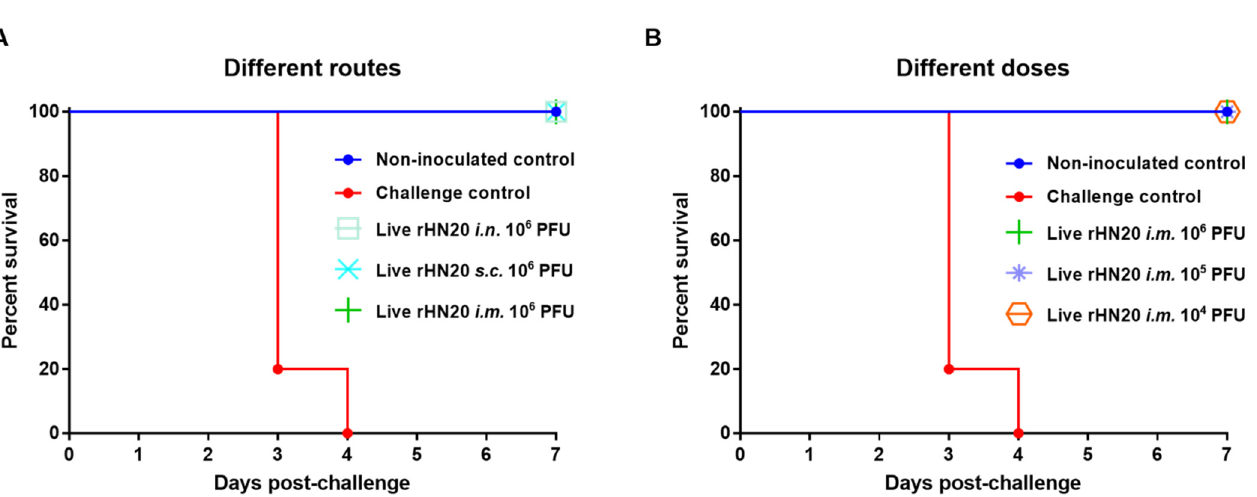
Figure 3. Protective efficacy of live rHN20 vaccine candidate against FAdV-4 challenge. Two weeks after immunization, all chickens were challenged with a lethal dose of FAdV-4. The survival rates of pre-immunized chickens via different routes ( A ) and different doses ( B ) were observed for 7 days. Data for the non-inoculated control group, i.m. 10 6 PFU group, and challenge control are shown in ( A , B ) are shared. Routes for immunization were: i.n. = intranasal, s.c. = subcutaneous, and i.m. = intramuscular.